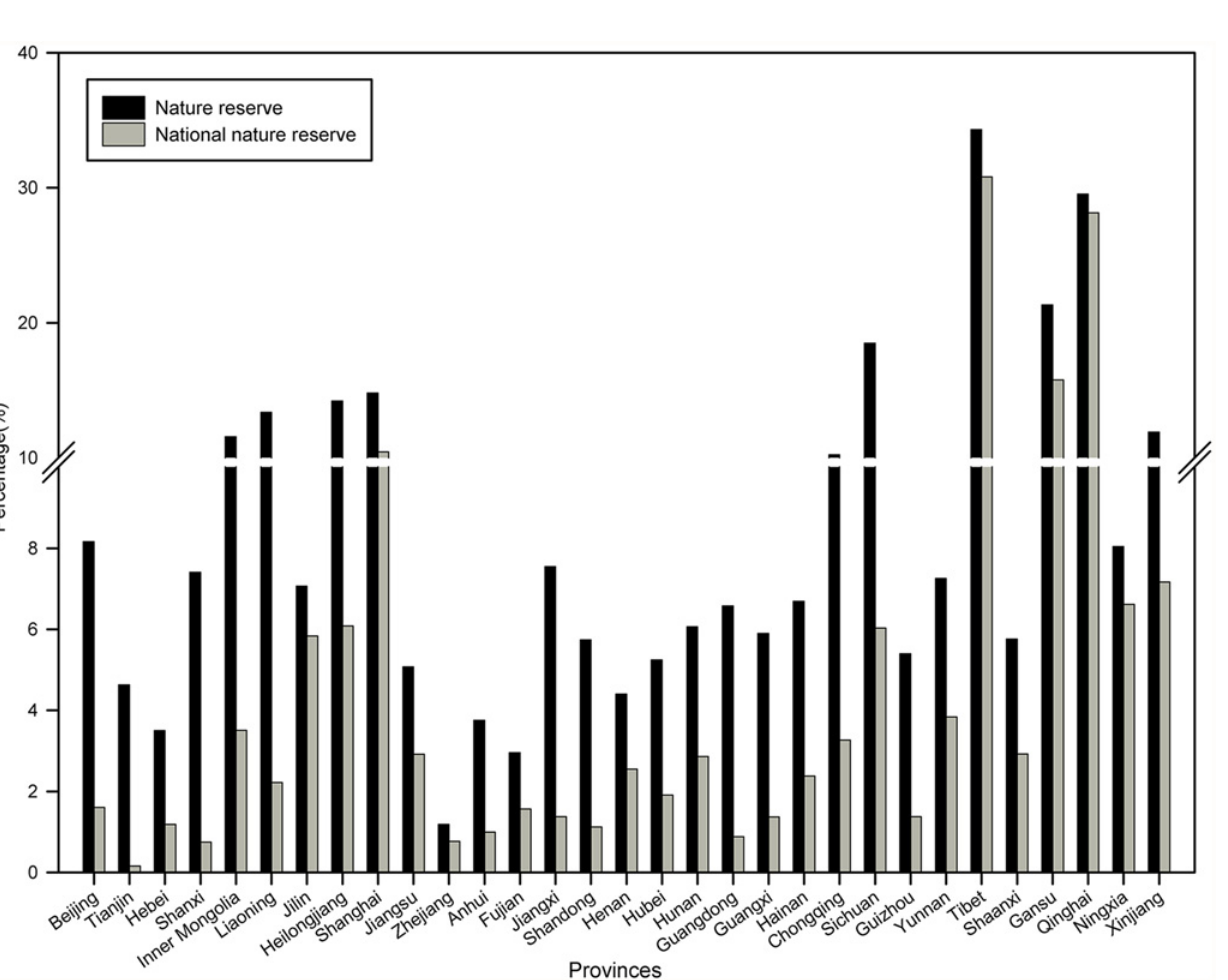
Fig 2. Proportion of land area covered by NRs and NNRs in different provinces.